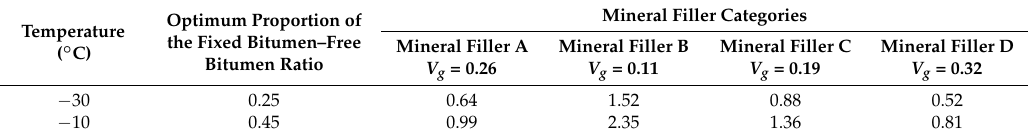
Table 5. Calculation Results of the Reasonable R FB in the SBS Polymer-Modified Bitumen